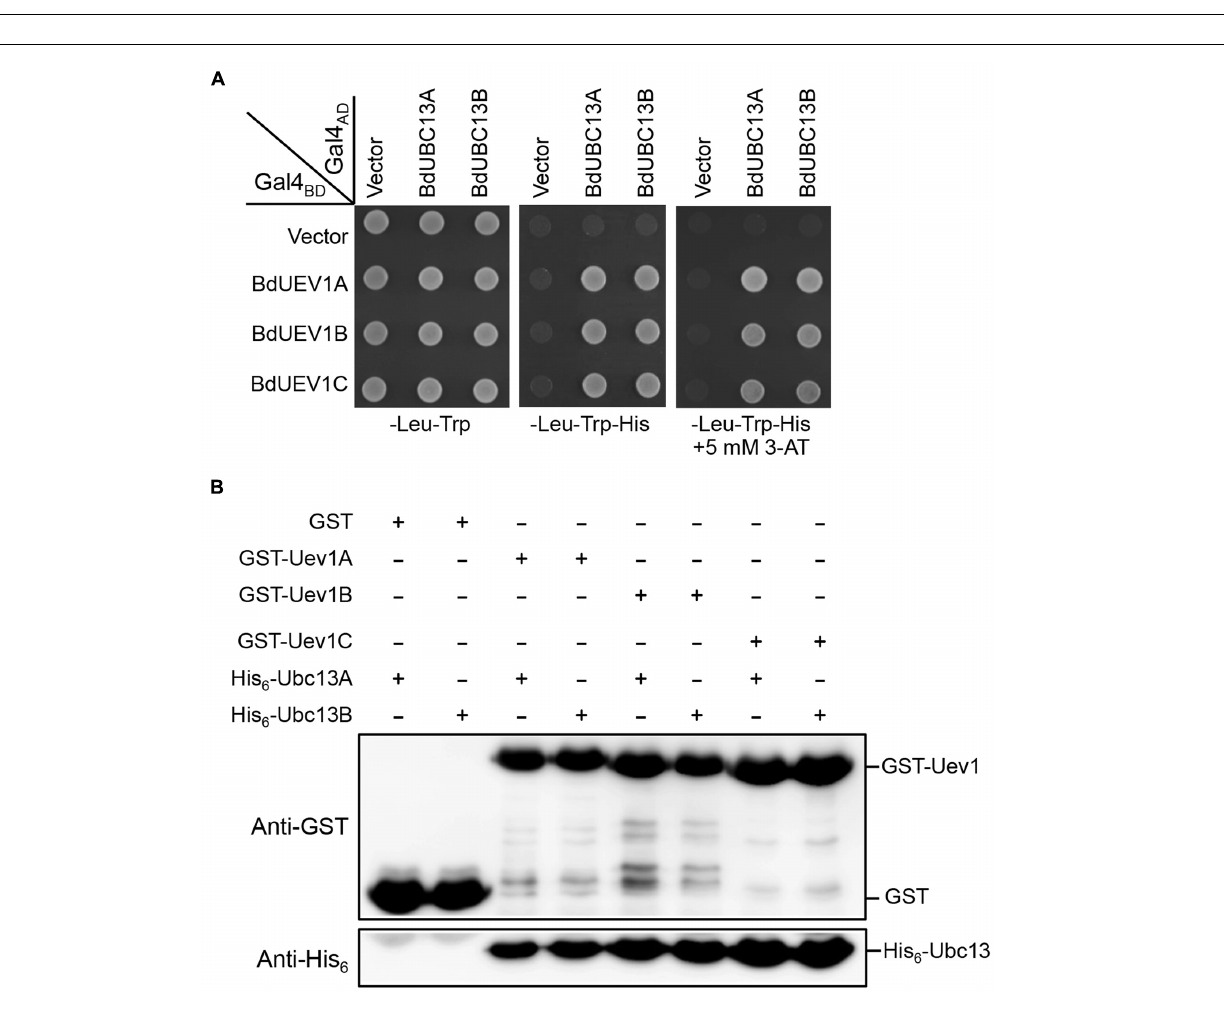
FIGURE 2 | BdUev1s physically interact with BdUbc13s. (A) Physical interaction between BdUev1s and BdUbc13s in a yeast two-hybrid assay. PJ69-4a cells were transformed with BdUEV1 s and BdUBC13 s genes and the transformants carrying one Gal4 BD (pGBT9) and one Gal4 AD (pGAD424) plasmid were then selected, replicated onto various plates as indicated and incubated for 3 days before being photographed. The result is representative of at least five independent transformants from each treatment. (B) Protein interactions between BdUev1s and BdUbc13s by an affinity pull-down assay. BL21 (DE3) cells were transformed with pGEX-BdUEV1s, and target gene expression was induced by adding 0.2 mM IPTG. Crude cell extracts were loaded on Glutathione Sepharose™ 4B beads and 10 µ g of purified His 6